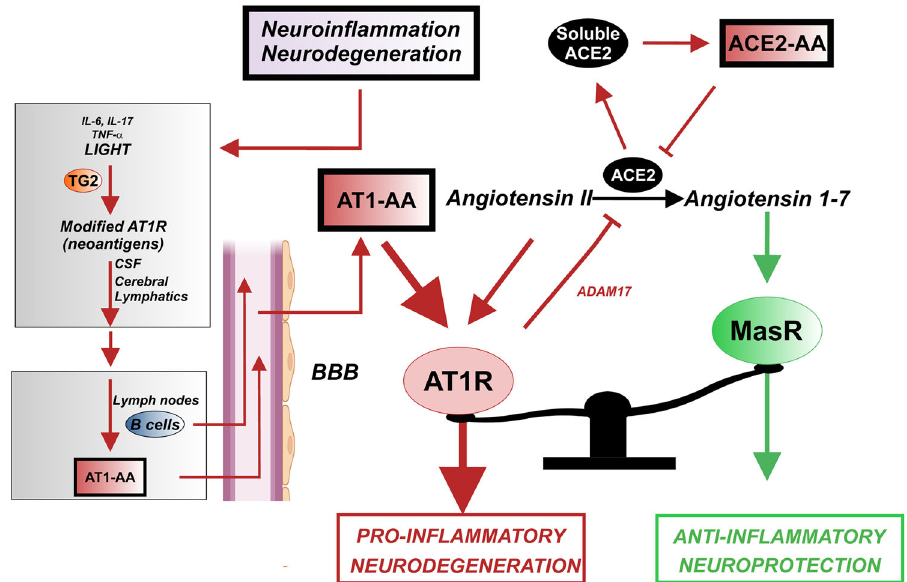
Fig. 5 Proposed model for AT1-AA and ACE2-AA generation and effects in PD. Dopaminergic degeneration/neuroin fl ammation induces an increase in modi fi ed AT1 receptors, possibly mediated by in fl ammation-related cytokines and transglutaminases (TG2), acting as neoantigens that reach the CSF. From the CSF, via the lymphatic system, neoantigens can drain into cervical lymph nodes. In the cervical nodes, B cells can respond against neural autoantigens, inducing antigen-speci fi c B cells and circulating autoantibodies. Activated B cells and/or